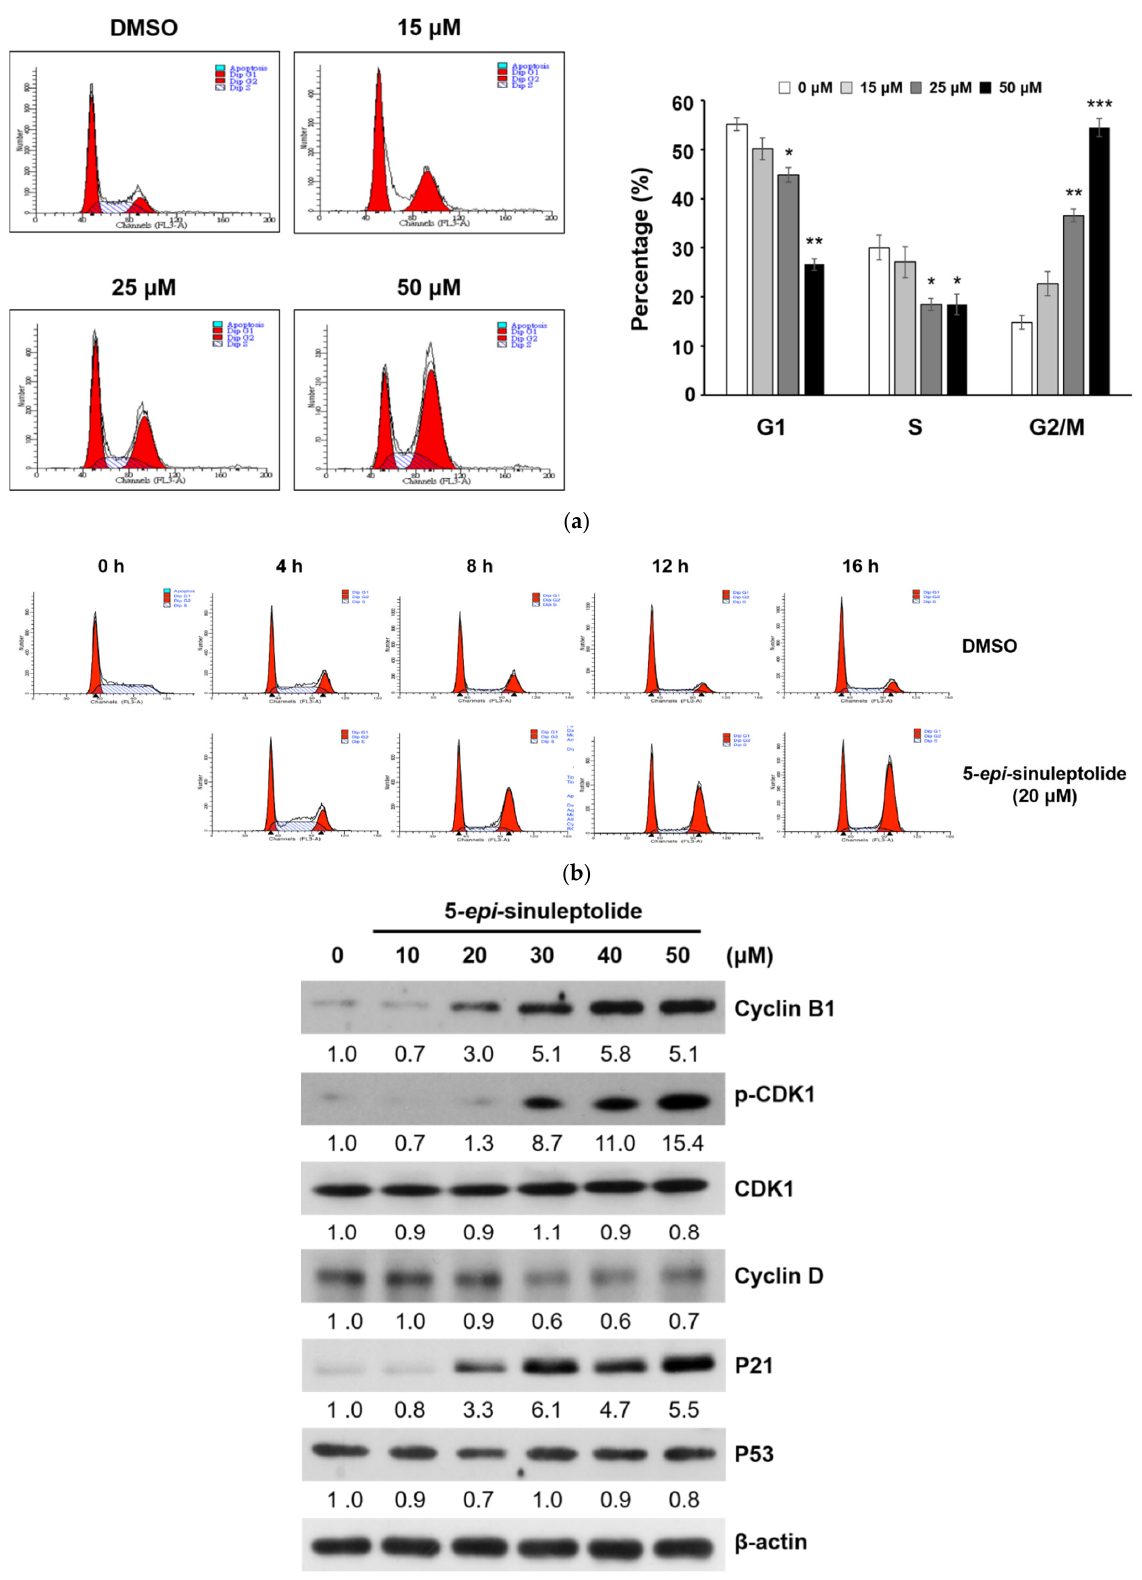
Figure 4. The aberrant cell survival of pancreatic cancer cells after 5- epi -sinuleptolide treatment is partially due to the inhibition of cell proliferation, especially G2/M arrest. Cell cycle analysis via flow cytometry using propidium iodide- stained BxPC-3 cells. Cells were treated for 24 h with 15, 25, and 50 μ M 5- epi -sinuleptolide. Data shown are representative of three independent experiments. The percentages of cells in the G1, S, and G2/M phase at each dose are illustrated as a bar graph shown in the right-hand side. Data are expressed as the mean ± standard deviation from at least three inde- pendent experiments. * indicates p < 0.05 vs. DMSO-treated control group, ** indicates p < 0.01, and *** p < 0.001 ( a ). DMSO- and 5- epi -sinuleptolide-treated cells were released from a double-thymidine block, and cell cycle distribution was deter- mined at the indicated time points. The cell cycle profile shown was obtained from one of three independent experiments ( b ). Representative Western blot bands showing the expression of proteins associated with G2/M progression; β -actin served as a loading control ( c ). The numbers under each blot represent values of corresponding band intensity relative to that of actin and untreated control. 2.4. 5-epi-Sinuleptolide Decreased the Invasion Ability of Pancreatic Cancer Cells and Suppressed the Protein Kinase B (AKT), Extracellular Signal-Regulated Kinase (ERK) 1/2, and Janus Kinase 2 (JAK2)/Signal Transducer and Activator of Transcription 3 (STAT3) Pathways Local cancer cell invasion represents the initial step of metastasis that dramatically worsens prognosis and patient survival. Numerous attempts have been made to interfere with this early event and to eradicate metastasis at its initiation [23]. An invasion assay was performed to determine the effect of 5- epi -sinuleptolide treatment on the invasion of pancreatic cancer cells. The invasiveness of PANC-1 cells was significantly suppressed via 5 -epi- sinuleptolide treatment (Figure 5a). This reduction was dose-dependent, with a 27%, 53%, and 69% decrease when cells were treated with 5, 10, and 15 μ M of 5-epi- sinu- leptolide, respectively. These results suggest that 5- epi -sinuleptolide may possess an anti- metastatic potential by inhibiting the invasion of pancreatic cancer cells. We further as- sessed the expression patterns of proteins involved in several classic pathways via west- ern blotting to determine the underlying mechanism by which 5- epi -sinuleptolide exerted its actions. The JAK/STAT signaling pathway plays a multitude of important biological functions in cell growth, differentiation, survival, and metastasis in many human cancers [24,25]. The effects of 5- epi -sinuleptolide on the expression of these proteins were